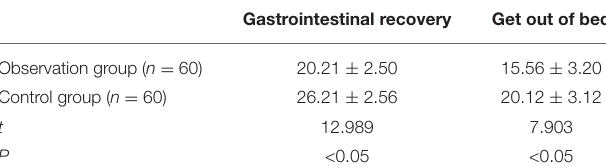
TABLE 3 | Post-operative recovery time of patients ( x ± s).